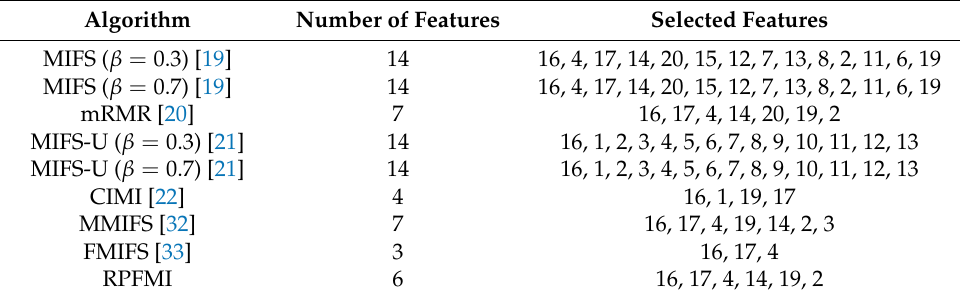
Table 11. Features selected by different feature selection algorithms.